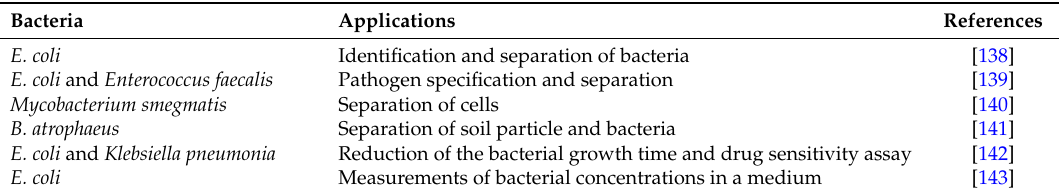
Table 7. DEP investigations of